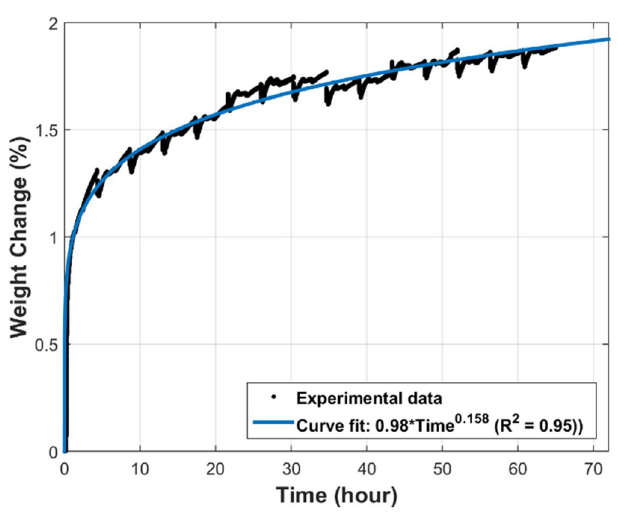
Figure 5. Percentage weight change of the FeCrAl fibers versus time during multiple MSHT